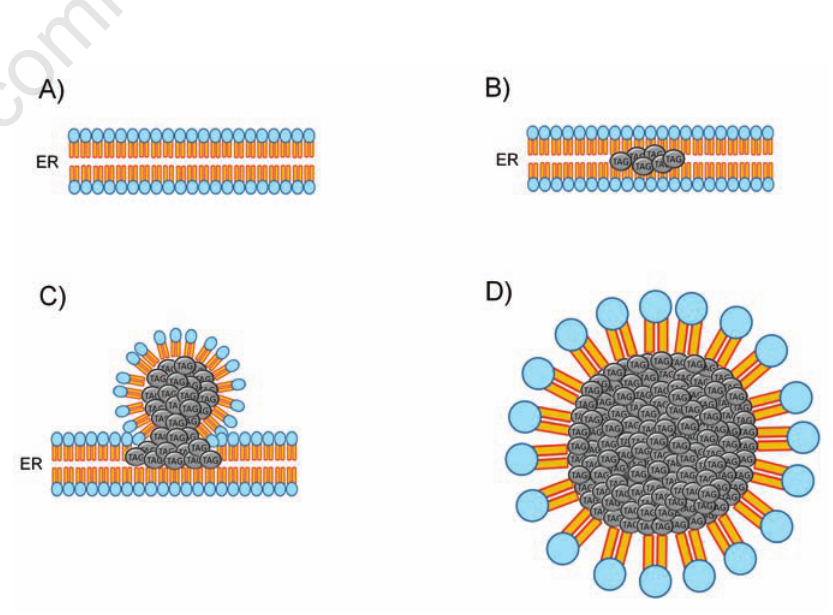
Figure 4. Oil body biosynthesis. (A-B) Accumulation of triacylglycerols (TAGs) occurs between the two layers of endoplasmic reticulum membrane (ER). (C) During ongoing synthesis of TAGs the droplet grows and forms a bud. (D) After reaching a certain size, the budding particle is released into the cytosol as a mature oil body. Adapted from Athenstaedt and Daum.